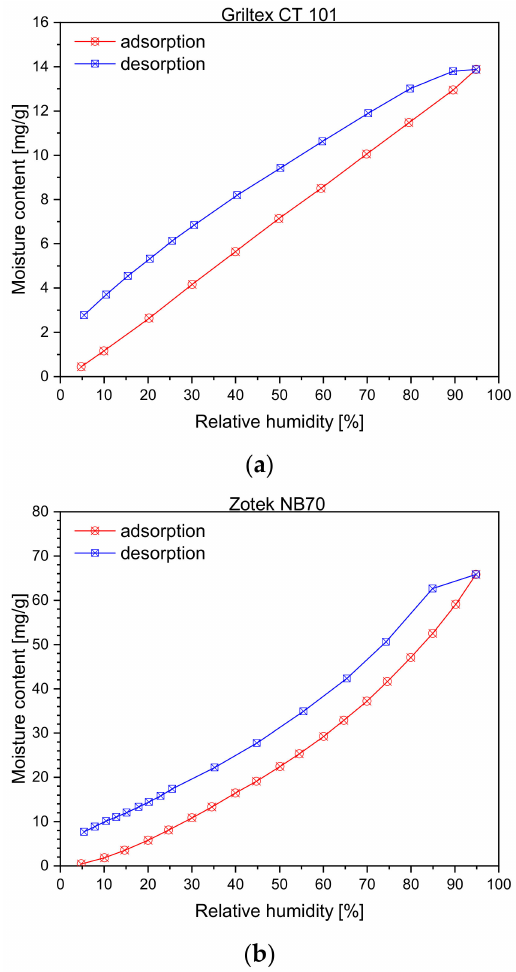
Figure 4. Sorption isotherms at 23 ◦ C of ( a ) binder powder Griltex CT 101 and ( b ) PA6 foam Zotek